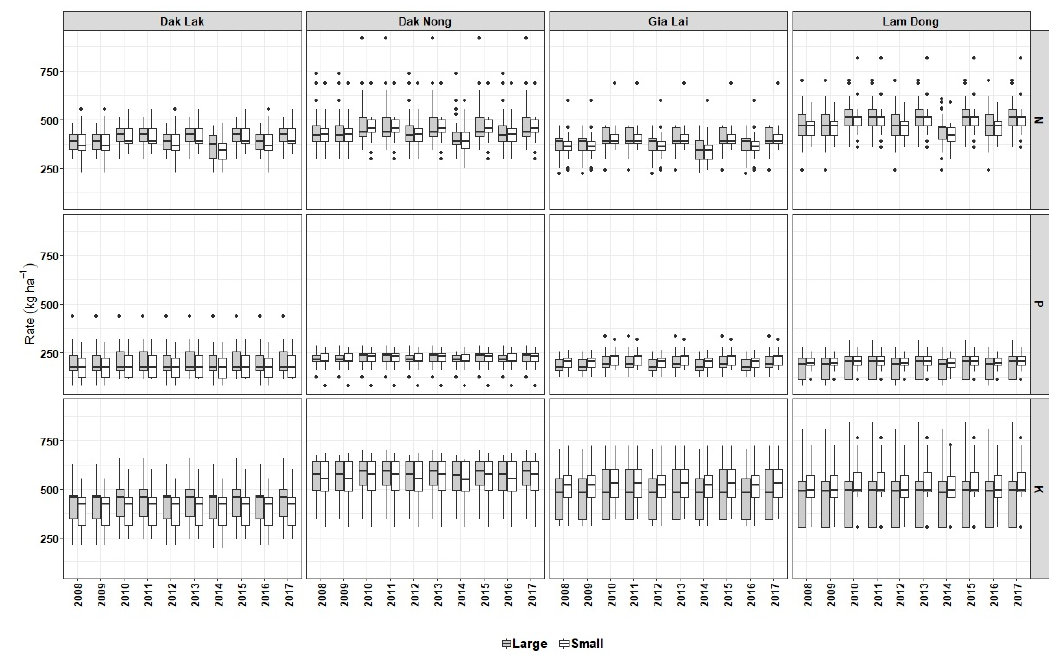
Figure 2. Year-to-year variations of nutrient rates in large- and small-scale Robusta coffee farms for each of the study provinces in Vietnam during the 2008–2017 period. The rates of nitrogen (N), phosphate (P 2 O 5 , referred to as P) and potassium (K 2 O, referred to as K) were calculated based of the nutrient contents of each the chemical fertilizers recorded (see Tables 2 and 3). In the boxplot, upper and lower borders of the box represent the 3 rd and 1 st quartiles, respectively. The line within the box represents the median value. Bars extend to the minimum and maximum values. Outliers are represented by black circles. Small-scale farms have area ≤ 1 ha; large-scale farms have area >1 ha.